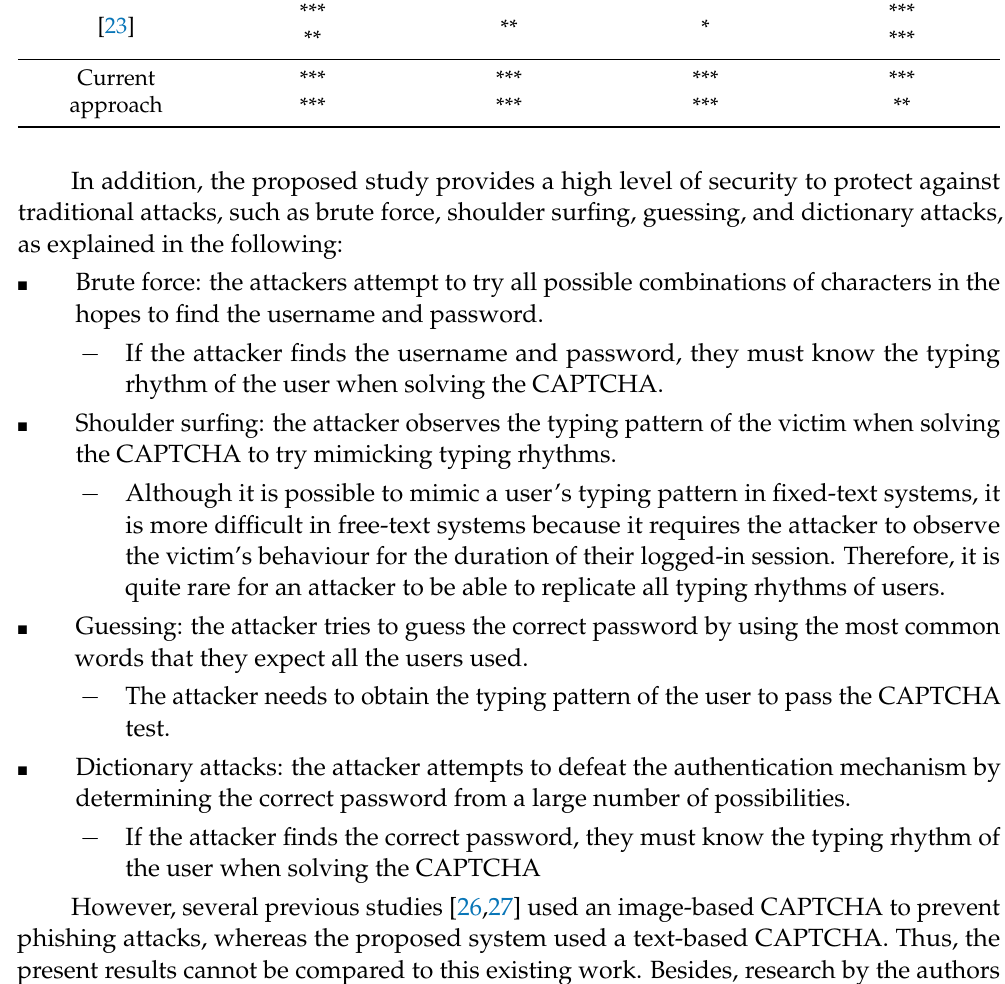
Cost- Observed Effectiveness Popularity